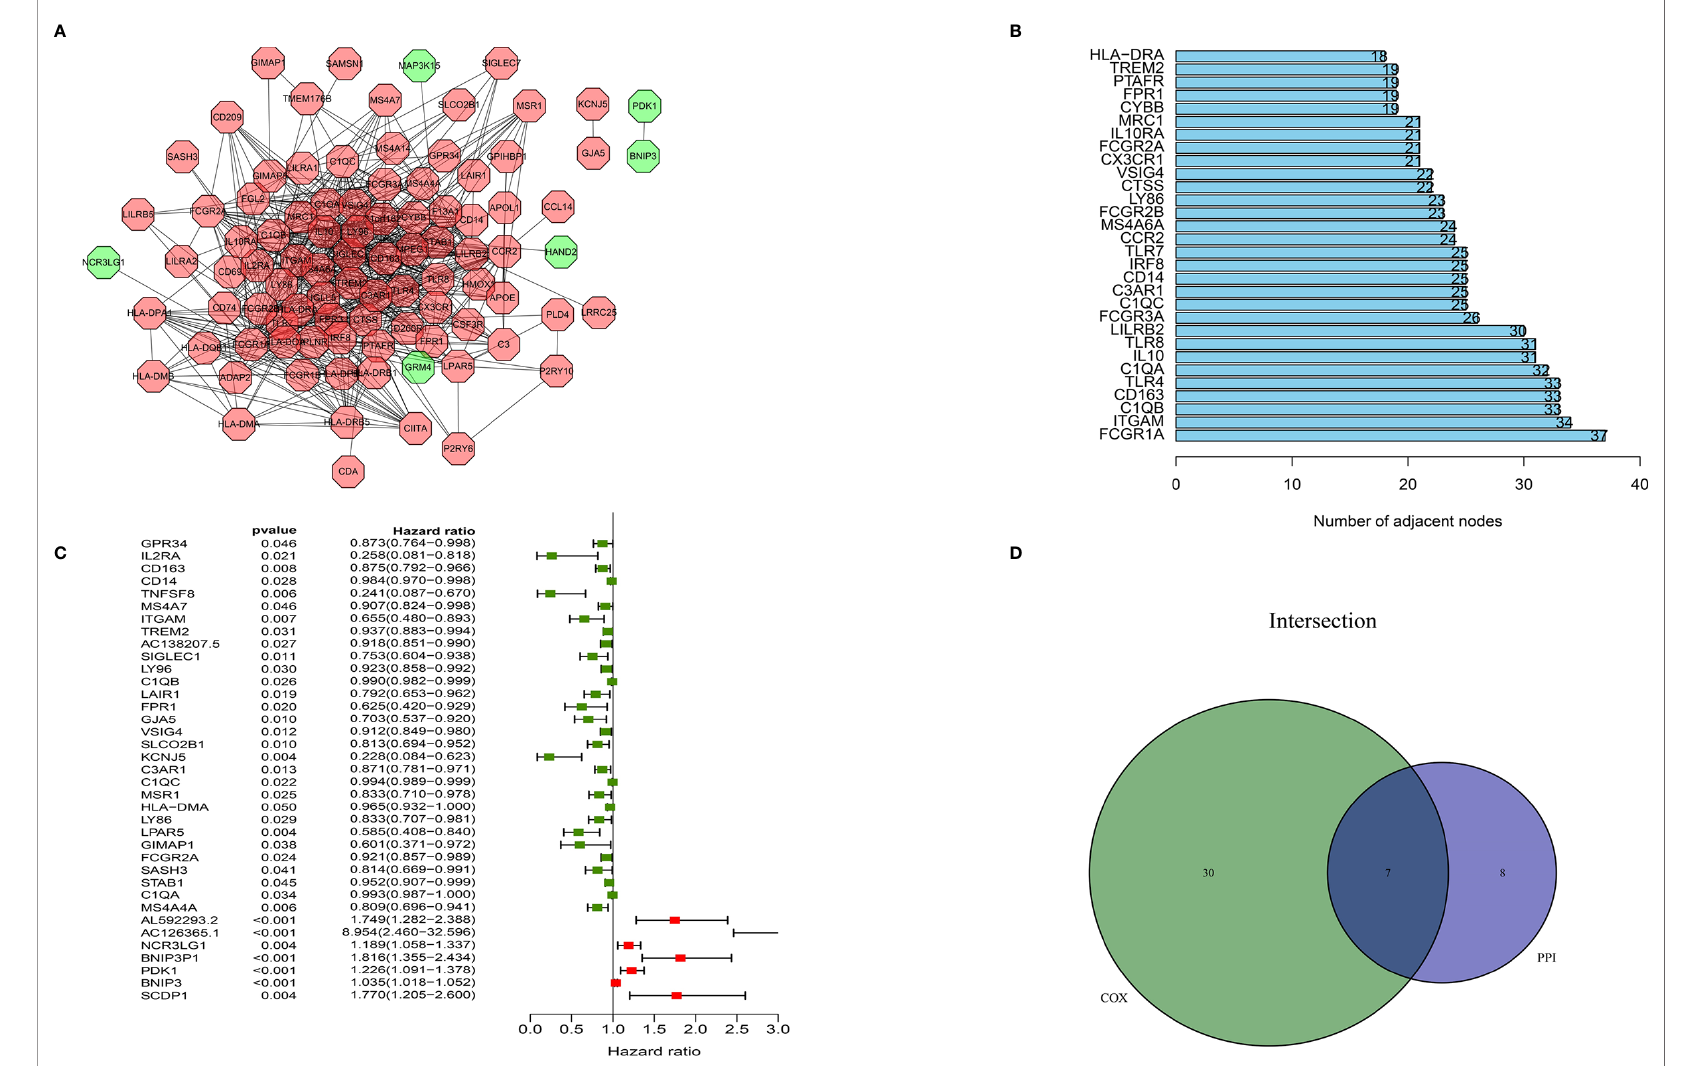
FIGURE 3 | Construction of a PPI network, univariate analysis by Cox regression analysis and intersection of the results. (A) Construction of the PPI network conducted using nodes with an interactive con fi dence value > 0.7. (B) Sorting of the top 30 genes on the basis of the number of PPI nodes. (C) The 155 DEGs were analyzed using univariate Cox regression analysis and the Kaplan-Meier test, and signi fi cant in fl uencing factors with P < 0.05 are listed. (D) Venn diagram constructed to identify the factors shared by the top 30 PPI nodes and the top 15 univariate Cox regression